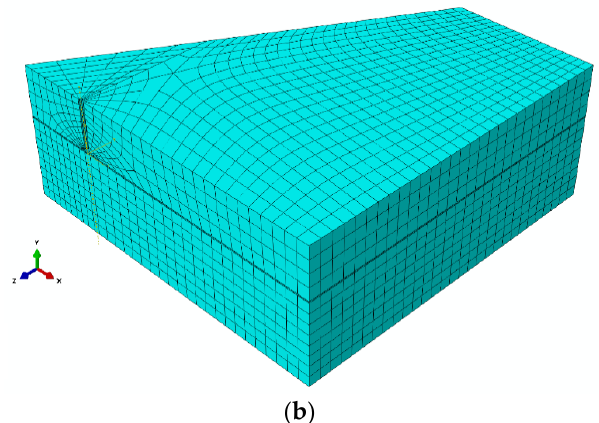
Figure 7. Model discretisation using the Finite Element Method: ( a ) full model, ( b ) the element mesh model obtained from the symmetry in the 3-anchor system.